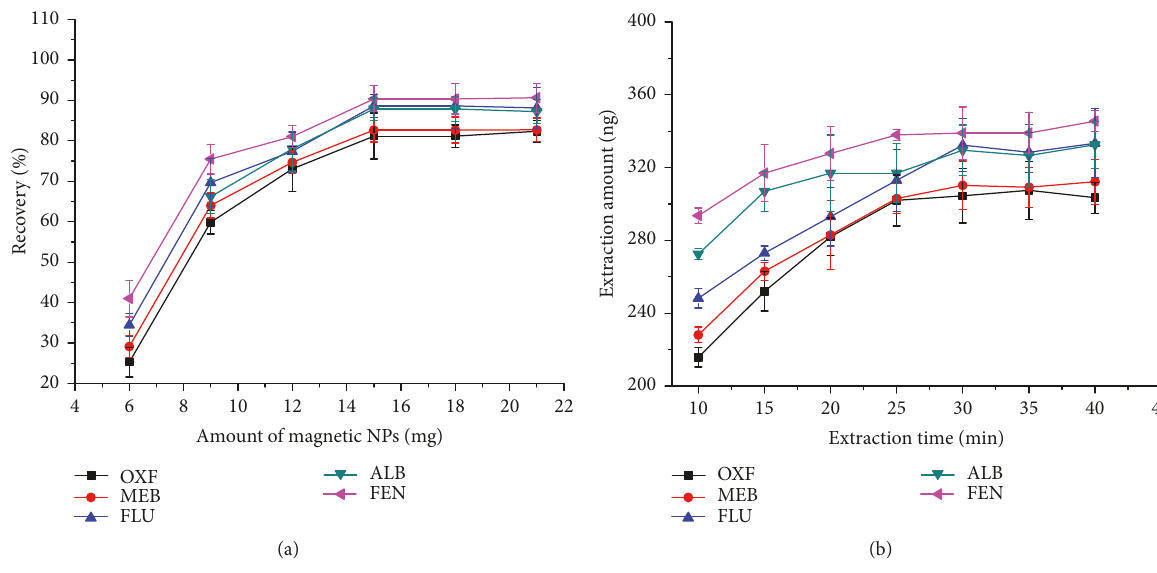
Figure 3: Effect of experimental conditions on the extraction efficiency. (a) Effect of the amount of sorbent and (b) effect of extraction time.